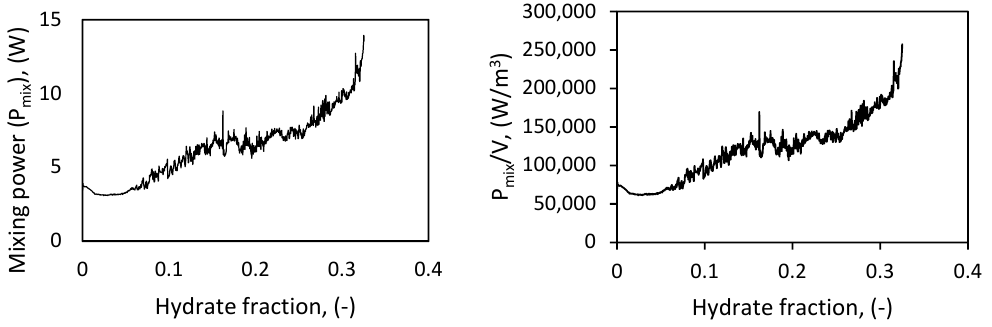
Figure 6. Impeller power consumption during hydrate growth.